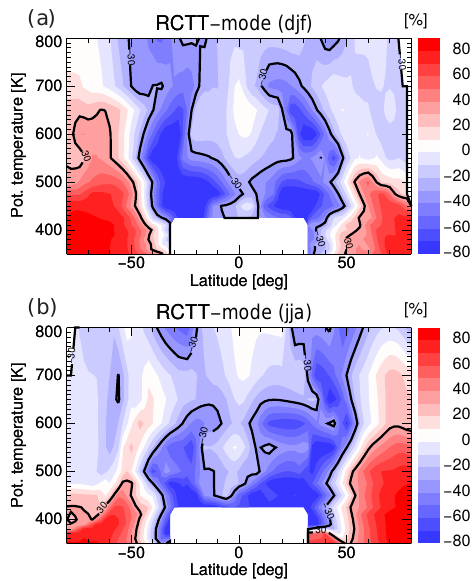
Figure 11. Difference between RCTT and modal age ( RCTT − mode )/ RCTT in percent for (a) December–February, and (b) June– August. The black line highlights the 30% contour. The tropical lowest stratosphere (below 420K) is left white as relative differ- ences become arbitrarily large there due to small transit times.